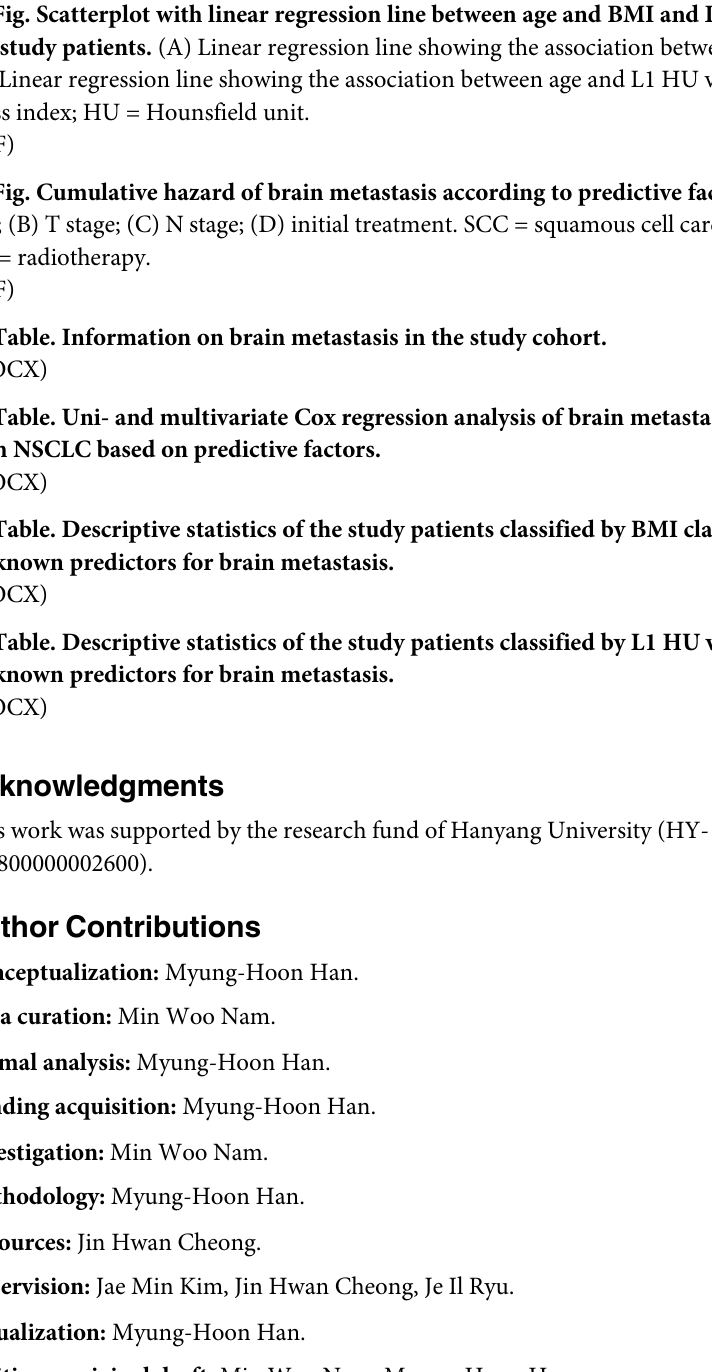
S1 Fig. Scatterplot with linear regression line between age and BMI and L1 HU values in the study patients. (A) Linear regression line showing the association between age and BMI; (B) Linear regression line showing the association between age and L1 HU values. BMI = body mass index; HU = Hounsfield unit. S2 Fig. Cumulative hazard of brain metastasis according to predictive factors. (A) histol- ogy; (B) T stage; (C) N stage; (D) initial treatment. SCC = squamous cell carcinoma; RT = radiotherapy. S1 Table. Information on brain metastasis in the study cohort. S2 Table. Uni- and multivariate Cox regression analysis of brain metastasis in patients with NSCLC based on predictive factors. S3 Table. Descriptive statistics of the study patients classified by BMI classification based on known predictors for brain metastasis. S4 Table. Descriptive statistics of the study patients classified by L1 HU value of 160 based on known predictors for brain